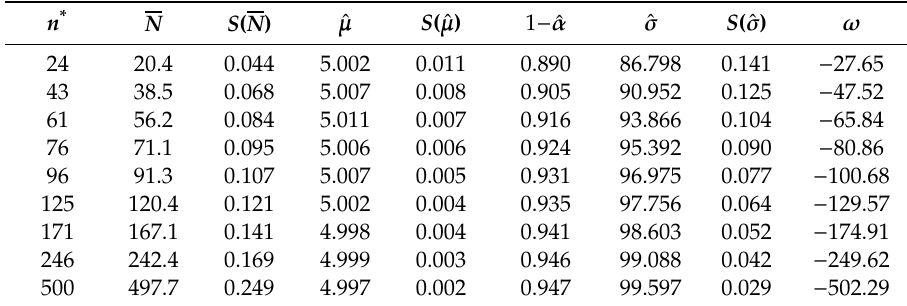
Table 2. Three-stage estimation of the mean and variance of the normal distribution under a unified stopping rule with m = 10, γ = 0.5, µ = 5, σ = 10, α =